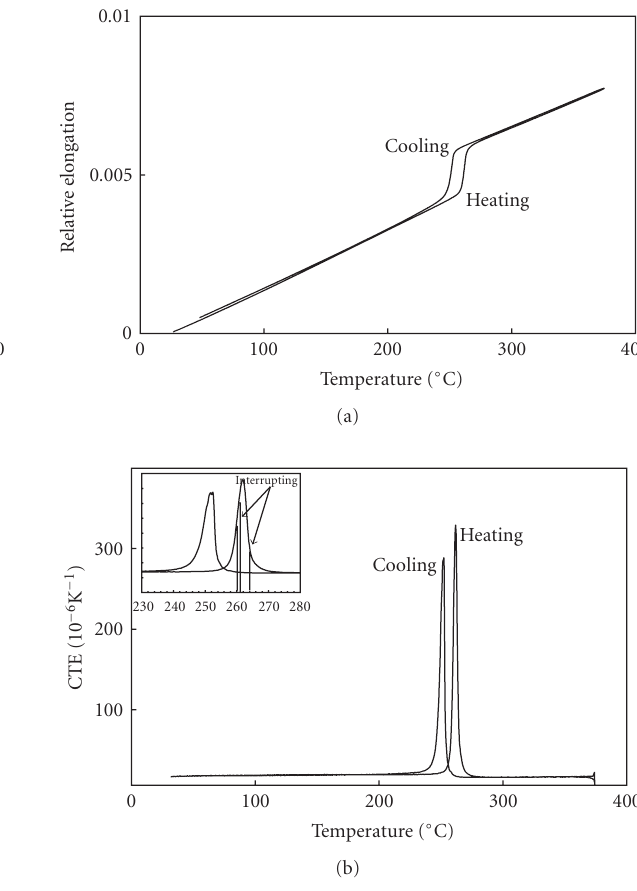
Figure 2: Temperature dependence of (a) the relative elongation and (b) the CTE for Ni 54 . 2 Mn 29 . 4 Ga 16 . 4 alloy in a complete